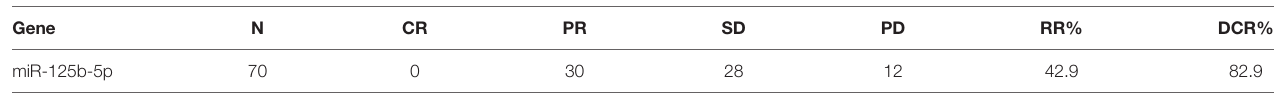
TABLE 3 | Response to the fi rst chemotherapy in serum exosomal miR-125b-5p.